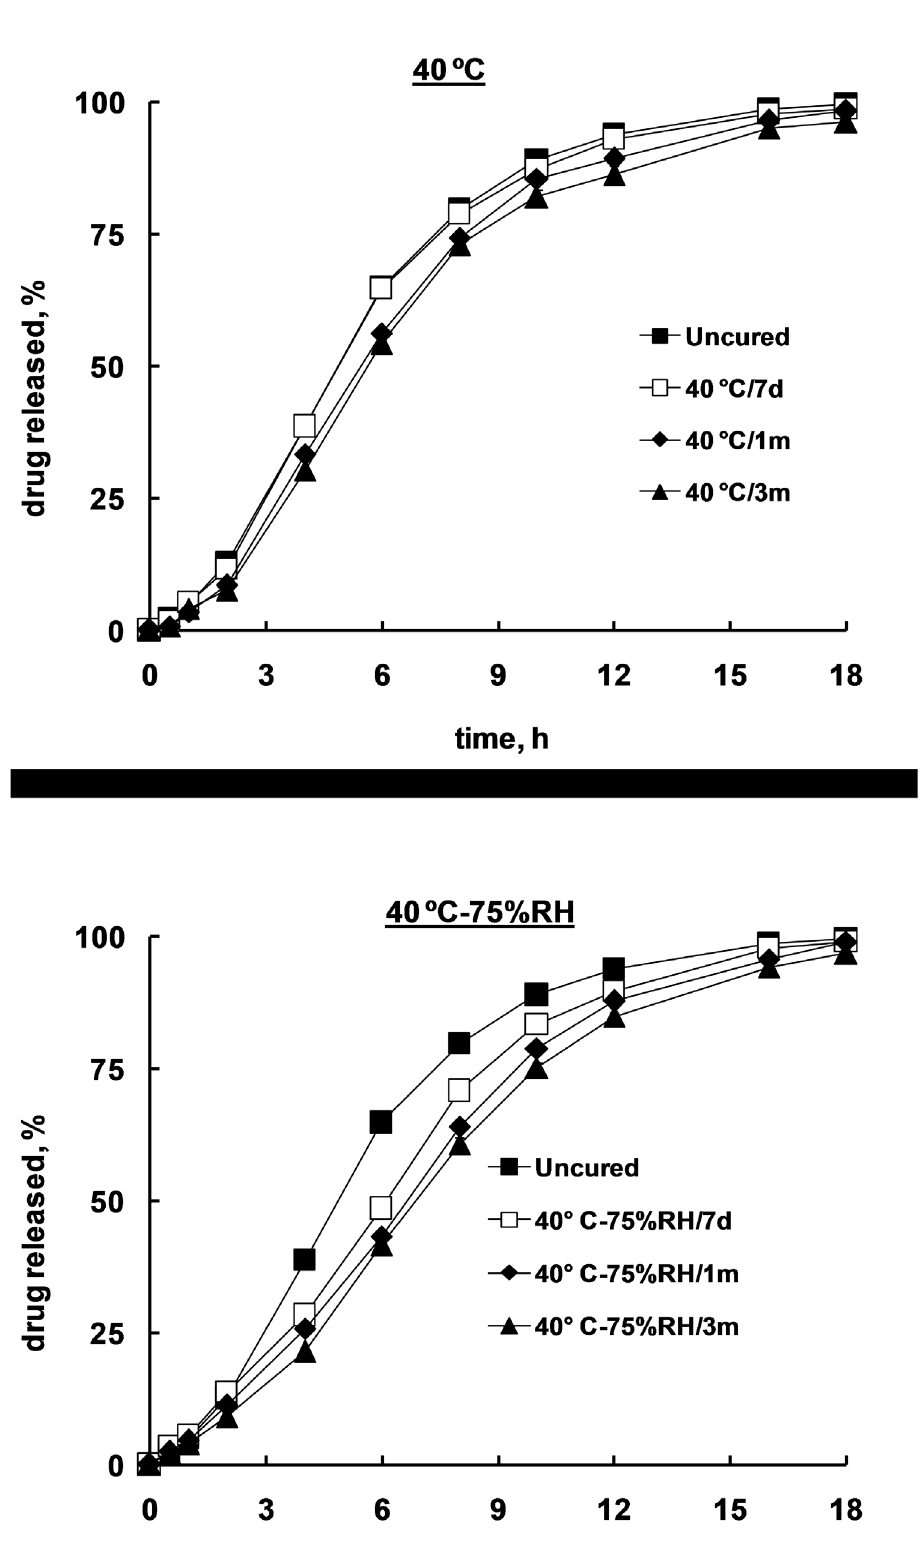
FIGURE 13 - Effect of accelerated storage conditions on the stability of propranolol HCl release from pellets based on sugar cores with 10% drug loading and coated with a polymer blend of Eudragit ® NE 30D: Aquacoat ® ECD (25:75) using 35% talc, coating level